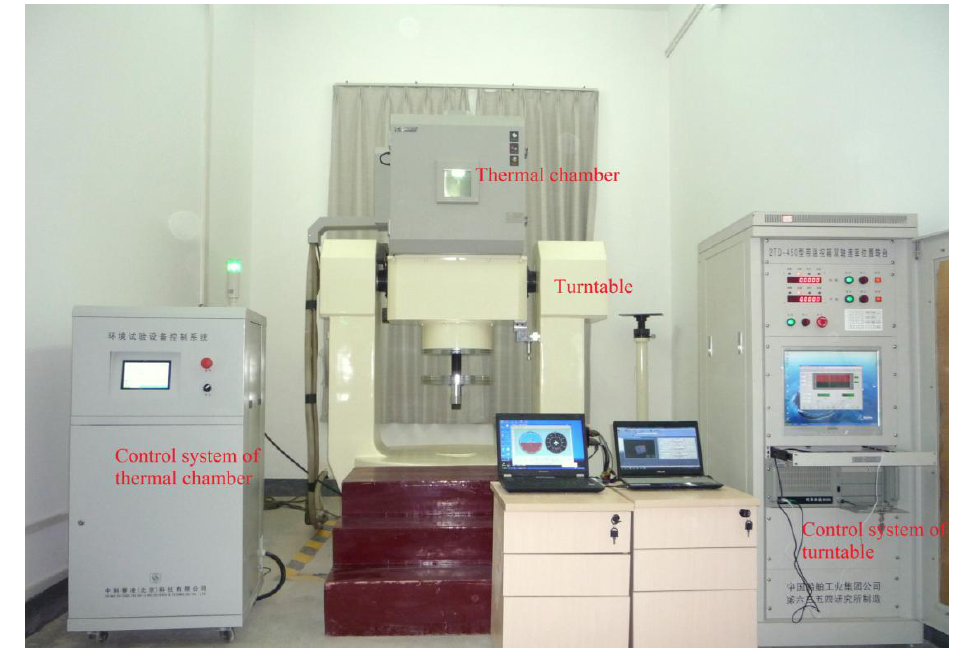
Figure 1. Thermal calibration equipment.